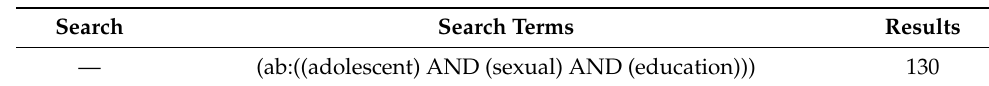
Table A4. Search at Scielo in 6 April 2021.